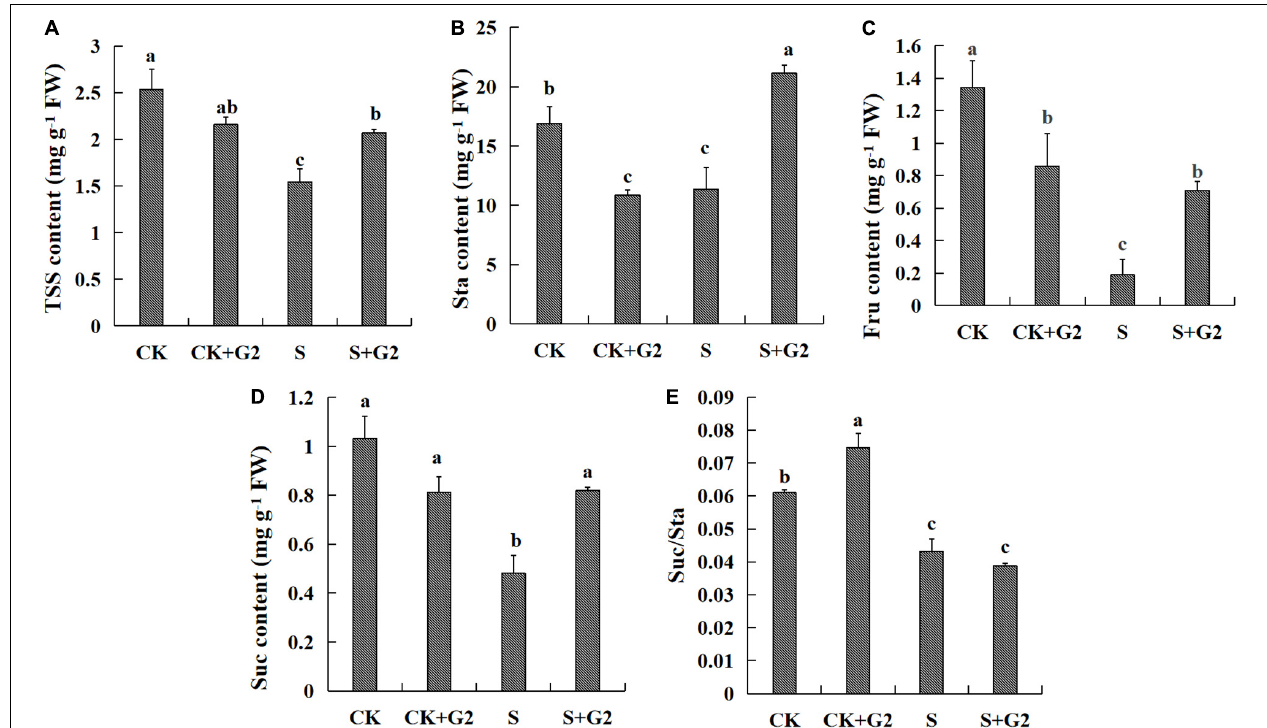
FIGURE 2 | Effects of B. cereus G2 on carbohydrates contents in G. uralensis seedlings under control and salt stress conditions. CK, control group; S, salt stress group; CK + G2, control combined with the G2 group; S + G2, salt stress combined with the G2 group. The different letters within the different treatments in the same parameter indicate the significant difference at the 0.05 level. Values are means ± SE ( n = 3). (A) TSS: total soluble sugar. (B) Sta: starch. (C) Fru: fructose. (D) Suc: sucrose. (E) Suc/Sta: sucrose/starch.